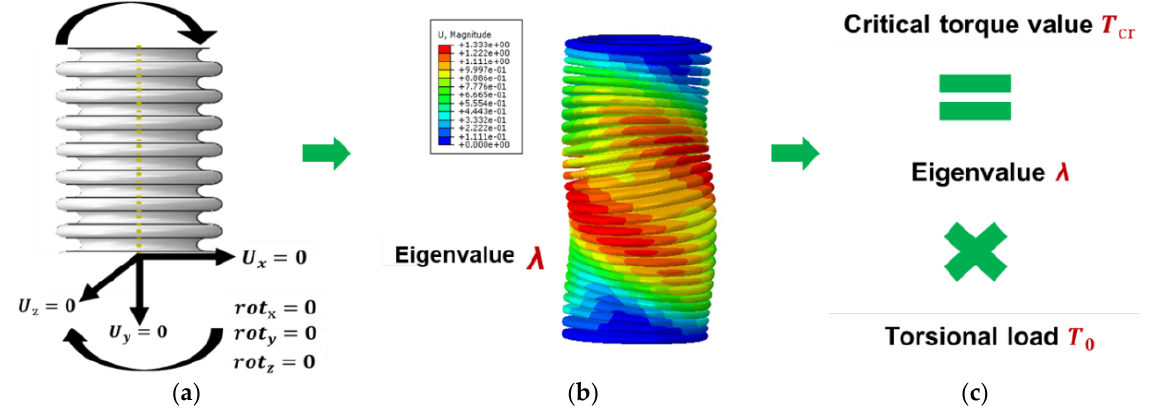
Figure 5. The process of first-order linear buckling of U-shaped bellows; ( a ) boundary conditions, ( b ) first-order buckling mode and ( c ) critical torque value.